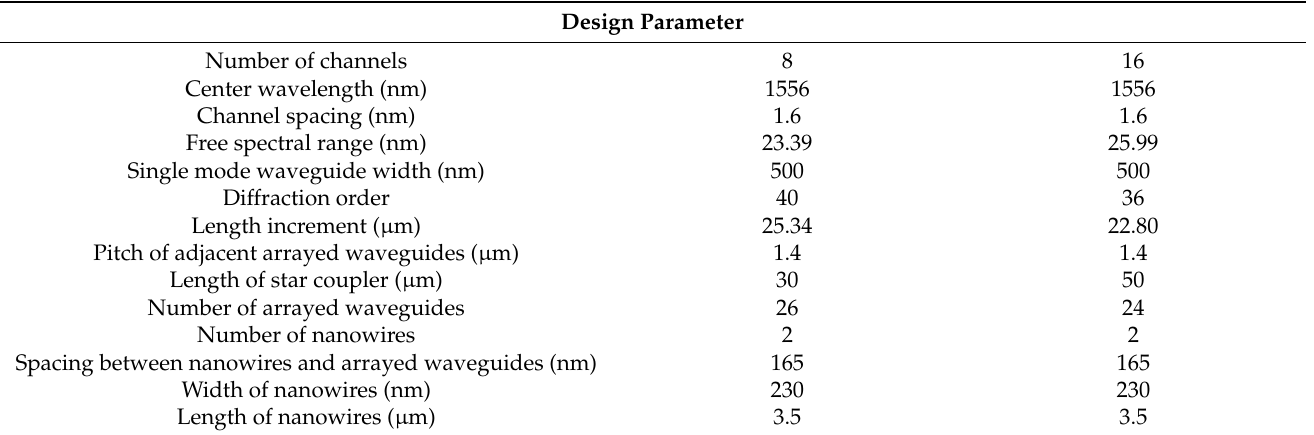
Table 1. Parameters of the nanowire-assisted